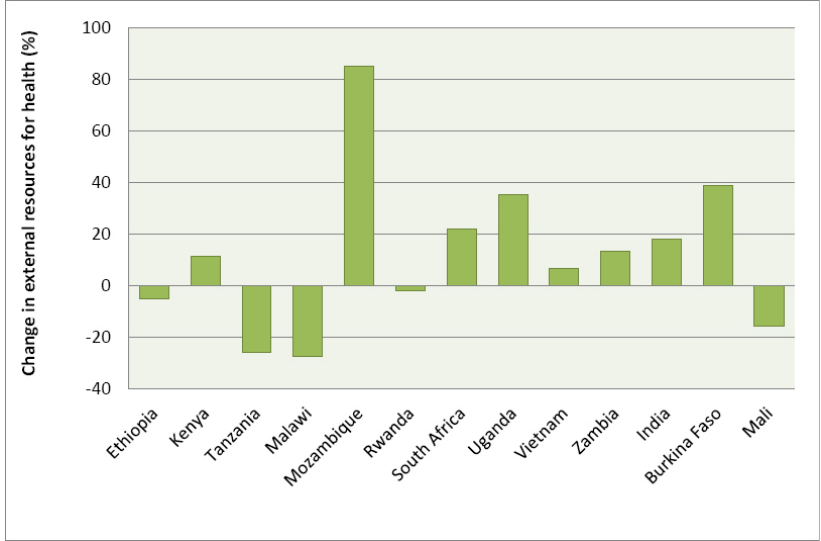
Figure 3. Percent Decrease in External Resources for Health from 2009-2010 in